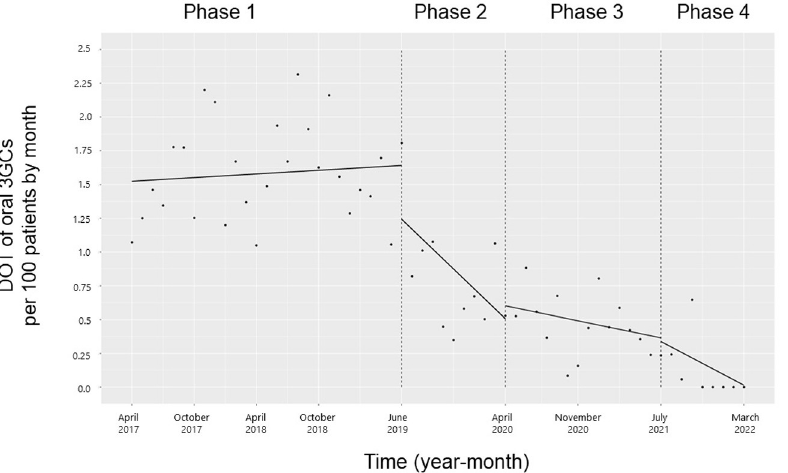
Fig 1. Trends in the days of third-generation cephalosporin therapy per 100 patients, by month, during Phases 1 to 4. Each dot refers to the third-generation cephalosporins (3GCs) per 100 patients each month, and the slope is based on the linear regression in the four phases: Phase 1 (pre-intervention period from April 1, 2017, to May 31, 2019); Phase 2 (review of clinical pathways from June 1, 2019, to March 31, 2020); Phase 3 (establishing an infectious disease (ID) consultation service and implementing the antimicrobial stewardship program (ASP) from April 1, 2020, to June 30, 2021); Phase 4 (educational lecture and pop-up displays for oral antimicrobials from July 1, 2021, to March 31,